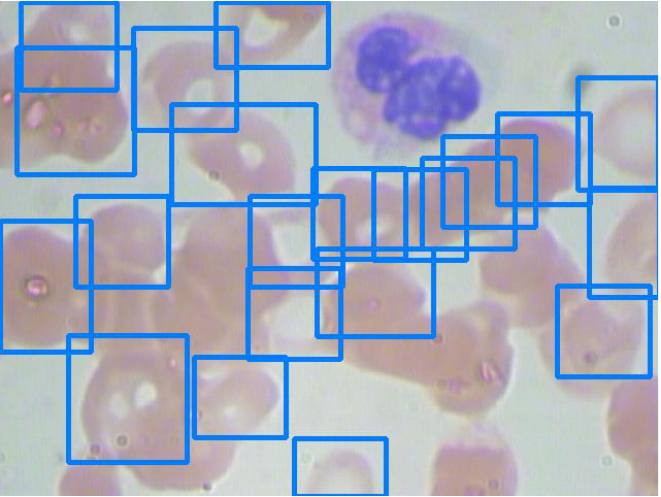
Figure 8. An image with overlapping red blood cells. Table 6. Comparison of the experiment results between Figure 7, Figure 8, and the validation set. Confidence Score: 0.9 Confidence Score: 0.8